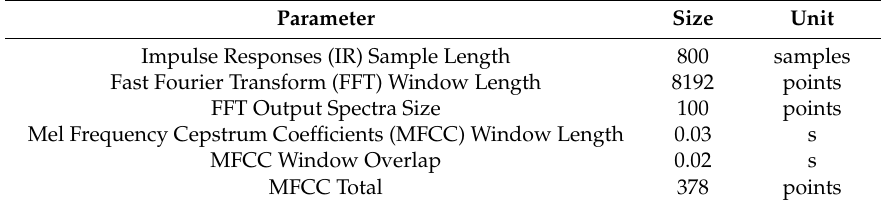
Table 2. Dataset